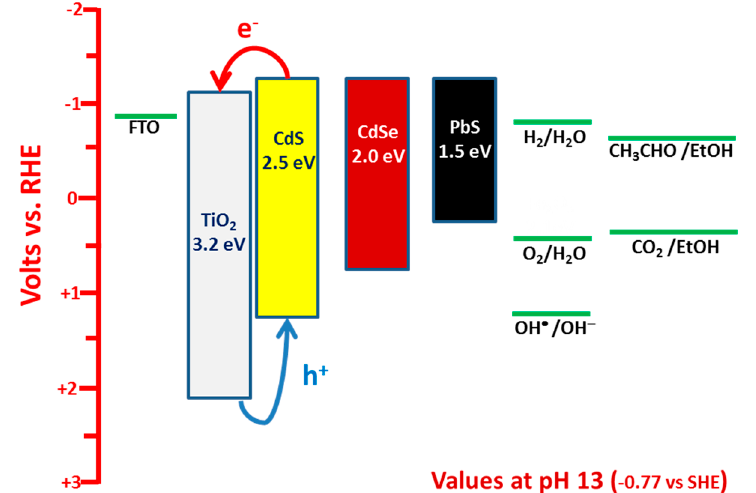
Figure 1. Approximate energy levels of a few semiconductors together with some characteristic redox potentials. The levels correspond to pH 13. They were negatively shifted with respect to the values at pH = 0, according to Equation (5). Thus at pH = 0 the potential of H 2 /H 2 O is zero. CdS, CdSe and PbS are shown as sensitizers by Fermi level alignment with TiO 2 . The band gap values correspond to quantum dot nanoparticles and are larger than in bulk